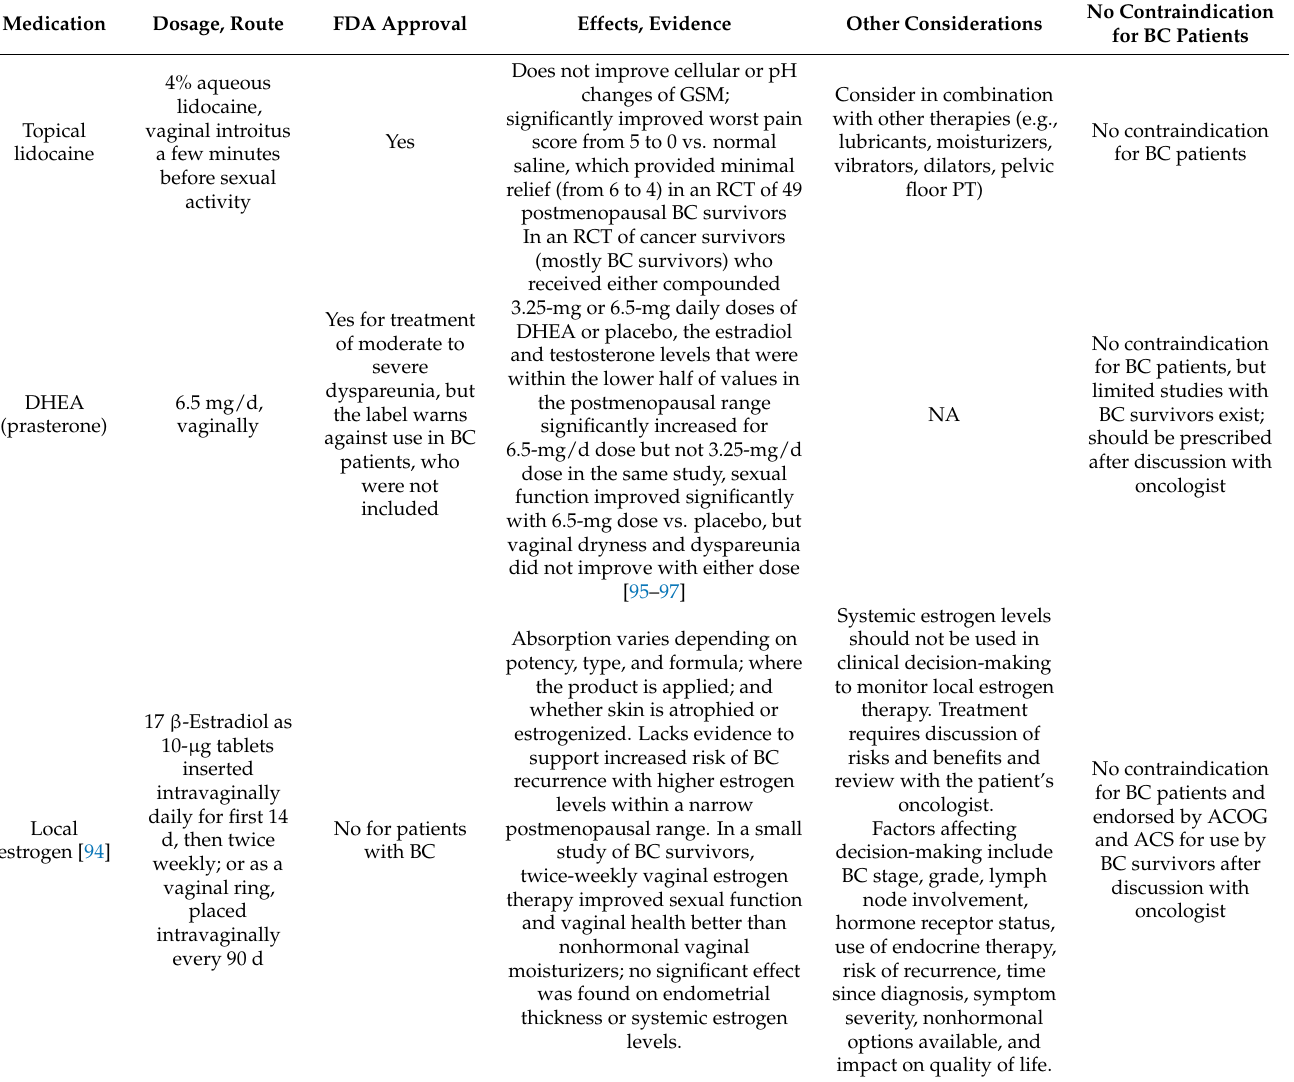
Table 4. Pharmacologic Treatment Strategies for